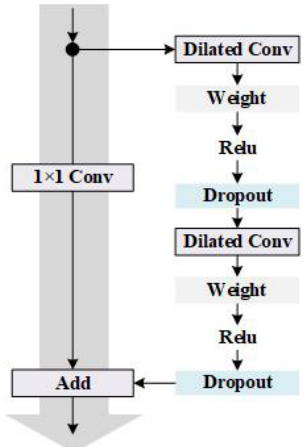
Figure 4. The residual module of Temporal Convolutional Network